Question: Briefly state, in one sentence, what is plotted here.
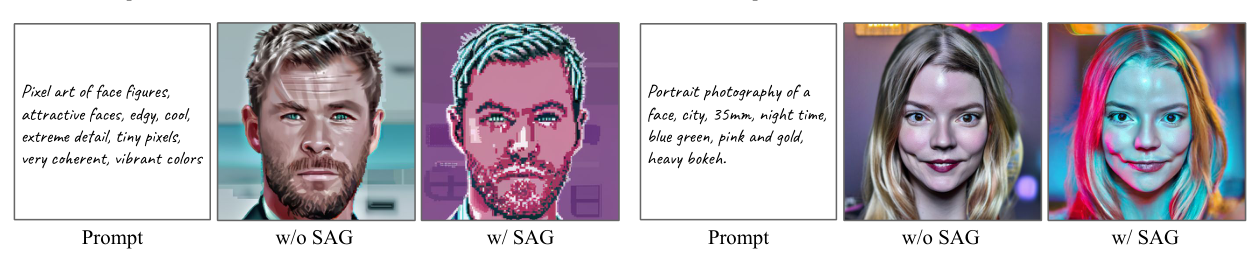
Answer: SAG on SuTI [10]. When applying SAG on SuTI, the subject is discarded during initial iterations, yielding outputs with markedly improved text alignment. Reference images are not provided to protect privacy.